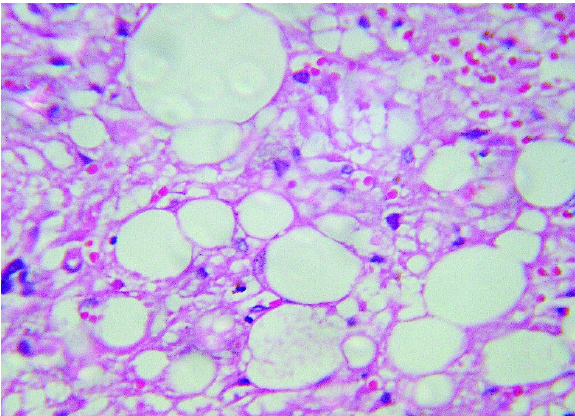
Figure 1 – The computerized tomography shows an expansive, solid, heterogeneous lesion with -38 UH attenuation, poorly de- fined, in the external edge of the left kidney’s lower third, mea- suring 3.8 x 3.8 cm and with preservation of perirenal fat.